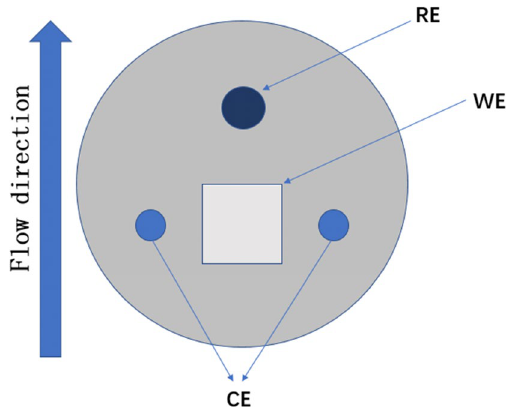
Figure 5. The macroscopic arrangement of the three-electrode setup.